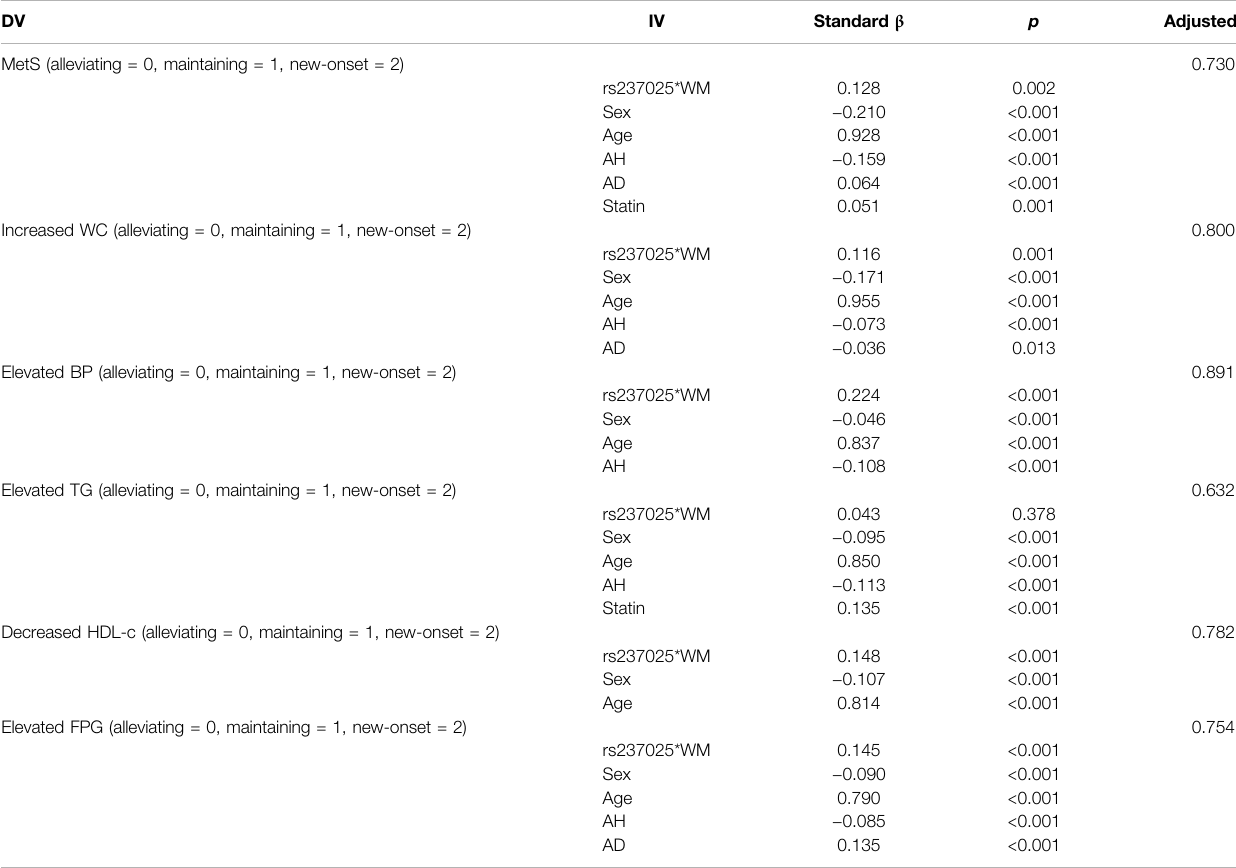
TABLE 6 | Liner regression analysis of changes in diagnose of MetS and MetS components. DV